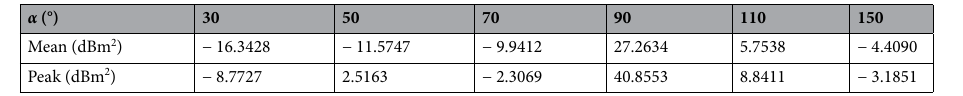
Table 9. RCS indicator of the aircraft, β = 0°, f RH = 6 GHz, ω m1 = ω m2 = 0.1963 rad/s, t = 0 ~ 4.407 s.